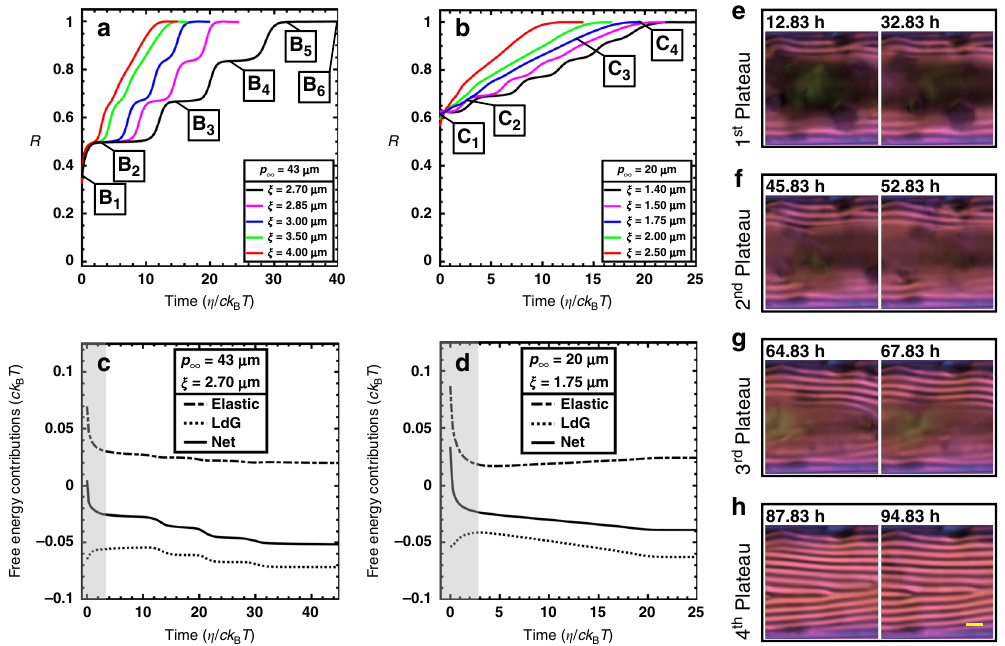
Fig. 4 The generic mechanism of relaxation dynamics. a, b Parametric analyses of the normalized relaxation progress, R , showing that smooth relaxation dynamics arise, provided coherence length is greater than a threshold. η stands for the rotational viscosity coef fi cient. c , d The interplay between homogeneous and elastic free energies, and the resulting net free energy. The gray-hatched zones indicate the period over which the order parameter of the para-nematic phase is dropped, Phase (I), and the remaining white-hatched zones correspond to front propagation, Phase (II). During the former and the latter, as can be appreciated by net free-energy behavior, elastic and homogeneous contributions mainly control net free energy, respectively. Note that all graphs exhibit the spatial-averaged quantities and the panels c and d correspond to the BLG and CNC relaxations, respectively. e – h POM images showing no signi fi cant change in the cholesteric zone during each of the four BLG plateaus marked in Fig. 1m. These POM images were experimentally acquired using the LC PolScope device. Scale bar is p ∞ = 43 µ